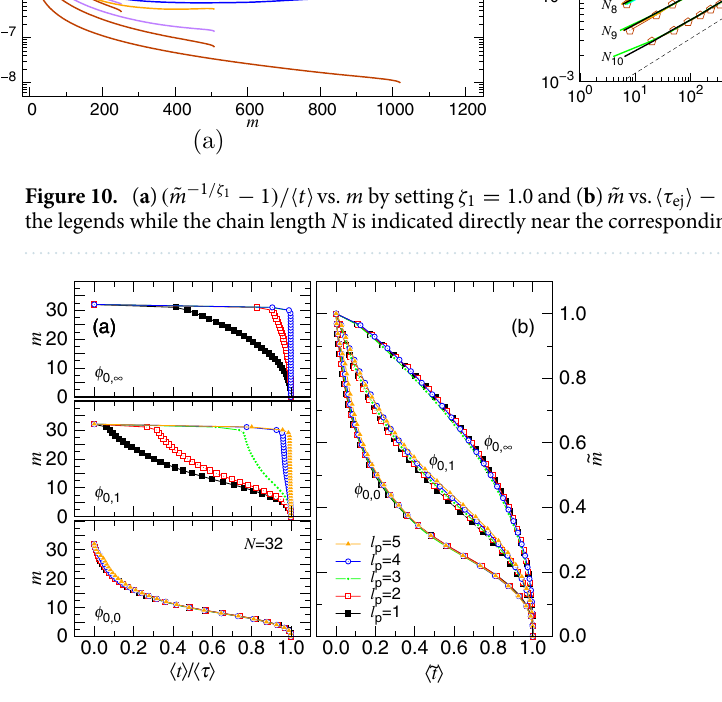
/ τ t for various pore length ℓ p at φ 0 (cid:31) (cid:30) (cid:31) (cid:30)